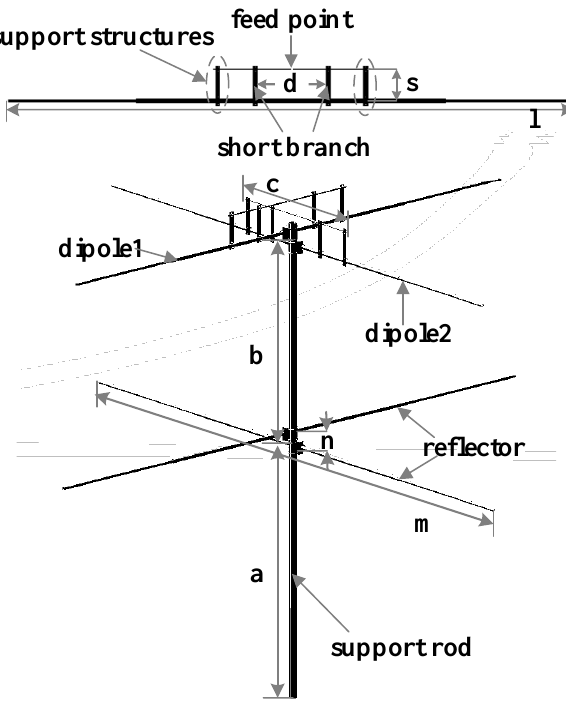
Figure 1. The simulation model of the designed turnstile antenna.